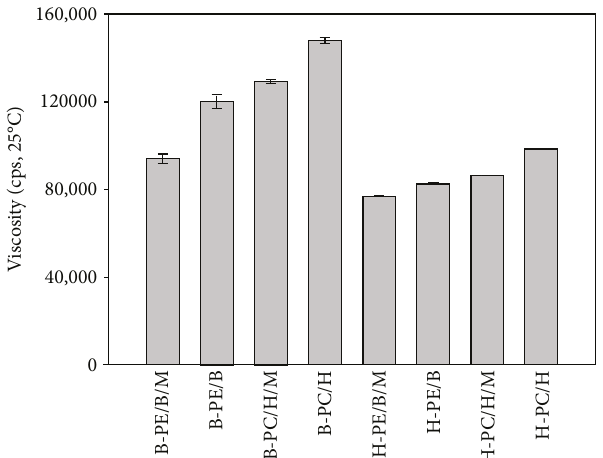
Figure 2: Viscosity of DMF-based polyurethane solutions (average value of fi ve tests).